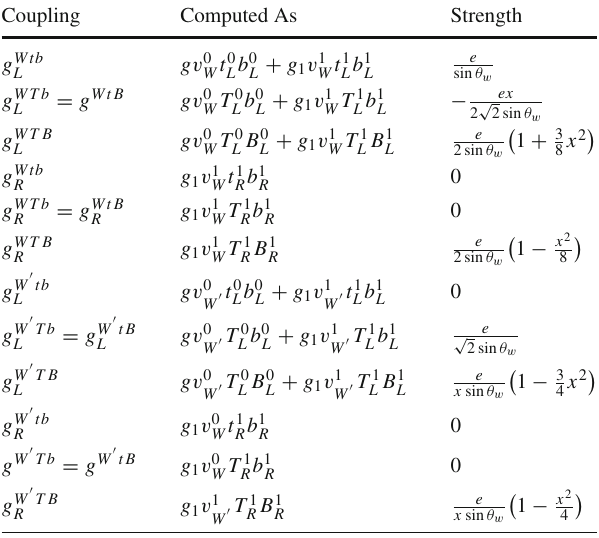
Table 7 Charged current interactions in the model calculated to O ( x 2 ) Coupling Computed As Strength